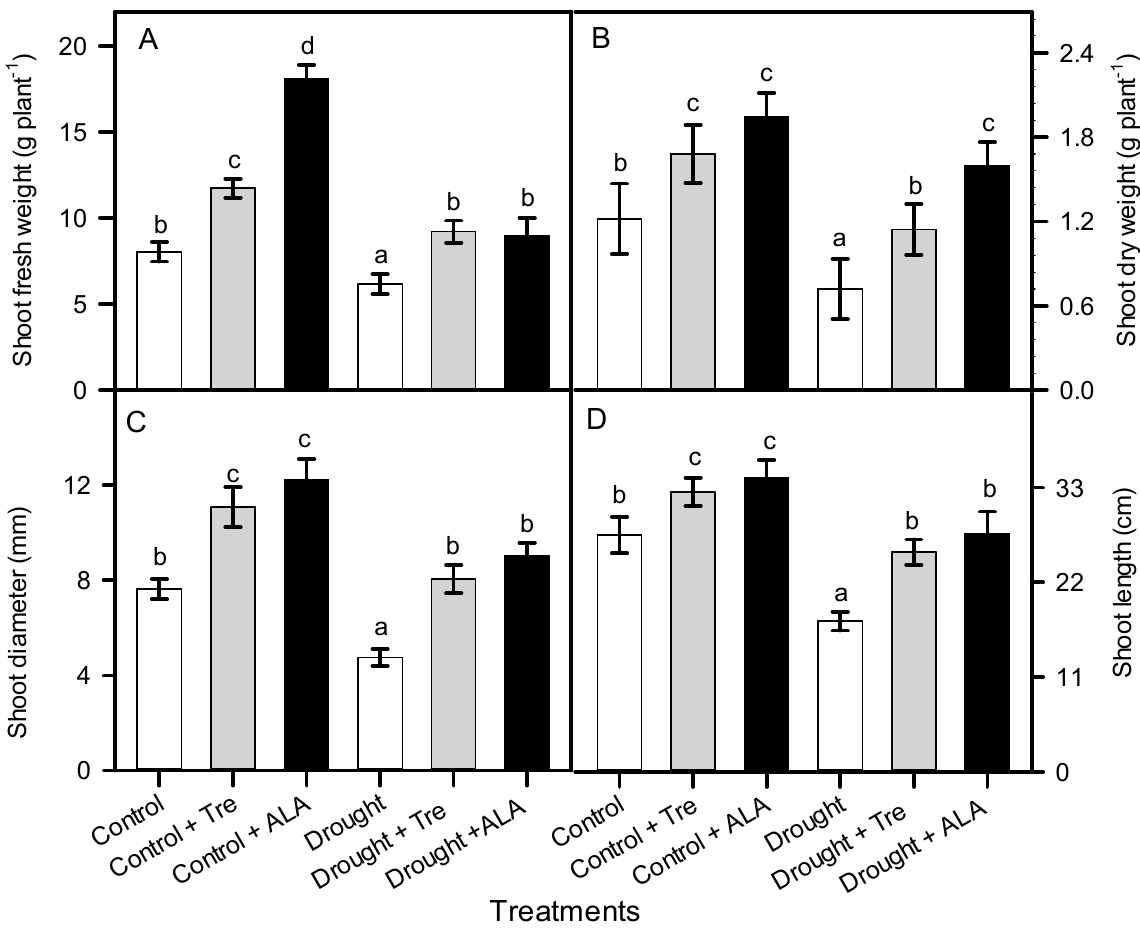
Figure 1. Shoot fresh weight ( A ), shoot dry weight ( B ), shoot diameter ( C ), and shoot length ( D ) of well-watered (100% FC, Control) and drought-stressed (65% FC, Drought) Alpinia zerumbet treated with foliar applications of water alone, 25 mM trehalose (Tre) or 10 mg L − 1 5-aminolevulinic acid (ALA). Values are means ± S.E. ( n = 6). Different letters above the bars indicate significant differences based on LSD analysis at p < 0.05.